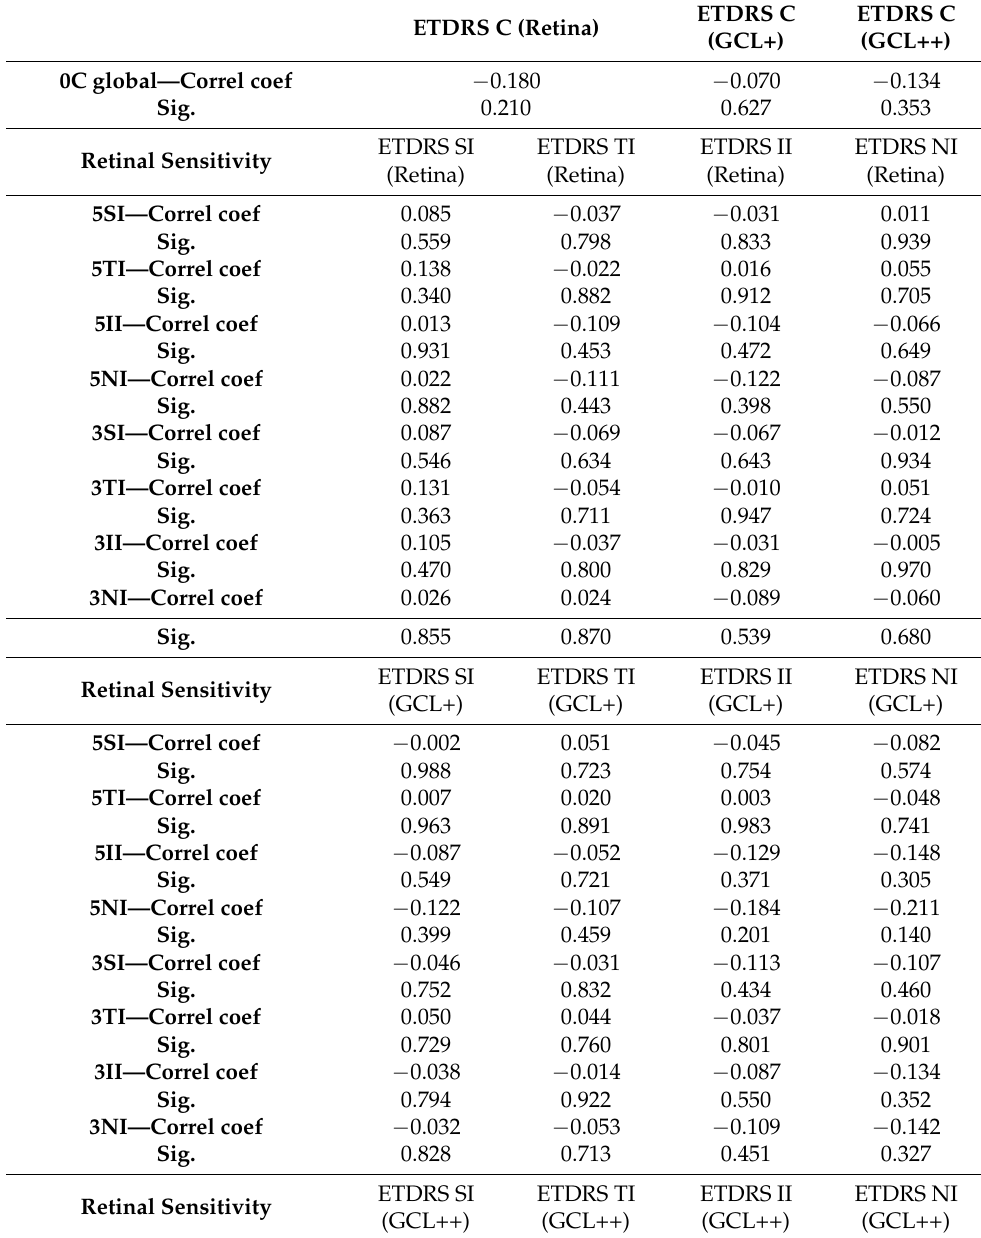
Table 4. Spearman’s correlation between the total retina (from the ILM to the BM line), GCL+ (from the RNFL to the IPL line) and GCL++ (from the ILM to the IPL line) thickness values in the central circle obtained by DRI Triton SS-OCT and the retinal sensitivity values obtained by the MAIA microperimeter in DM1 patients. Then, Spearman’s correlation between the parafoveal ETDRS areas (SI, TI, II and NI) of the total retina, GCL+ and GCL++ thickness layers measured by DRI Triton SS-OCT and the retinal sensitivity thresholds of the 3- and 5-degree radii measured by the MAIA microperimeter in the DM1 group. Statistically significant differences are in bold (sig. p < 0.05). The 9 ETDRS areas are as follows: C global, central global ring; SE, superior external; TE, temporal external; IE, inferior external; NE, nasal external; SI, superior internal; TI, temporal internal; II, inferior internal; and NI, nasal internal; correl coef, correlation coefficient; sig, statistically significant. ETDRS C